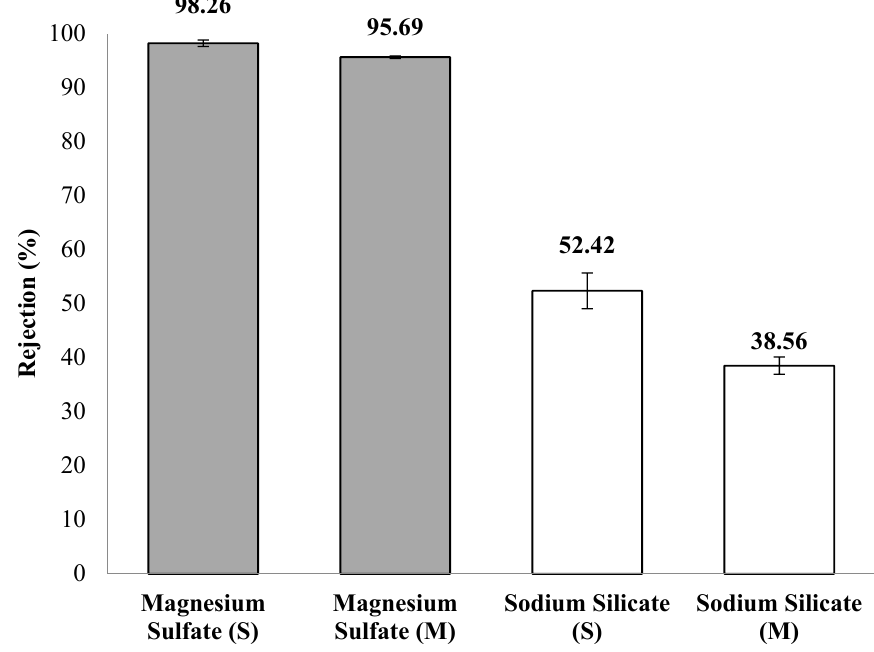
Figure 6. Magnesium sulfate (grey) and sodium nitrate apparent rejection (white) in the single (S) and mixed (M) solutions. Experimental conditions: feed pressure = 10 bar, 25 °C.